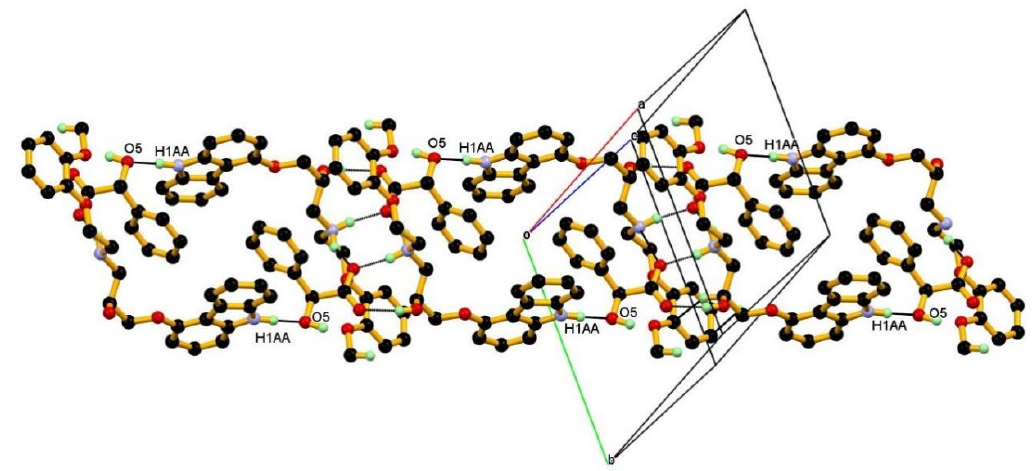
Figure 4. Linking of dimeric units via N1–H1AA ··· O5 hydrogen bonding to form a 1D-dimeric chain.